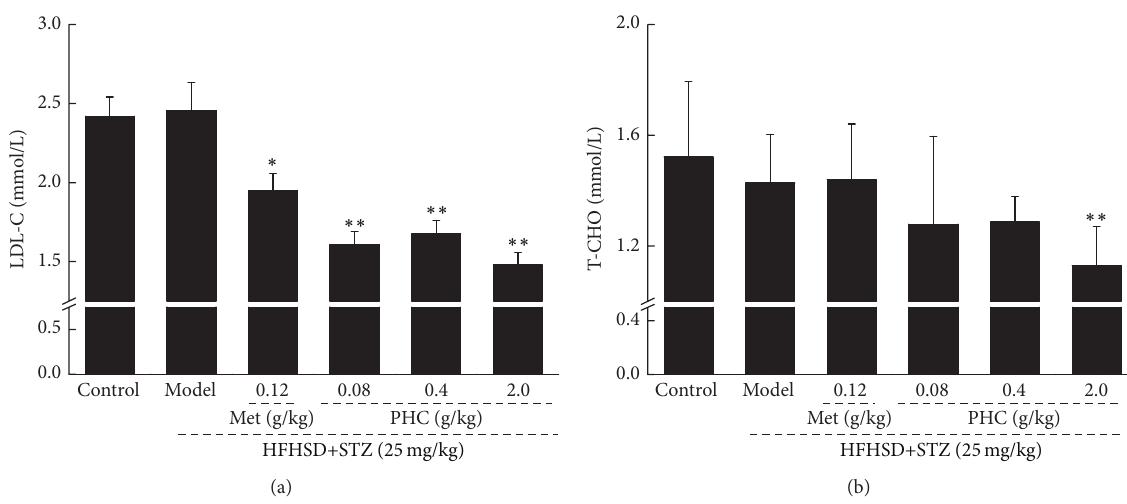
Figure 4: Four-week Met and PHC treatment strongly reduced the serum levels of LDL-C (a) and T-CHO (b) in diet-STZ-induced diabetic rats. Data are expressed as mean ± SD ( 𝑛 = 10 ) and analyzed by using one-way ANOVA. ∗ 𝑃 < 0.05 and ∗∗ 𝑃 < 0.01 versus model group.